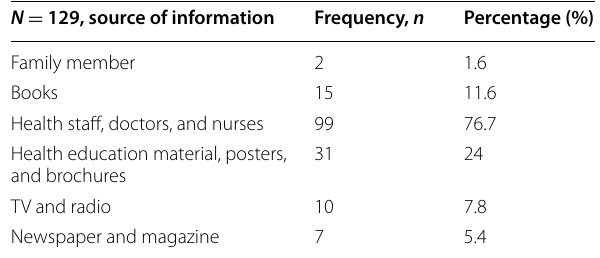
Table 6 Preferred source of information by